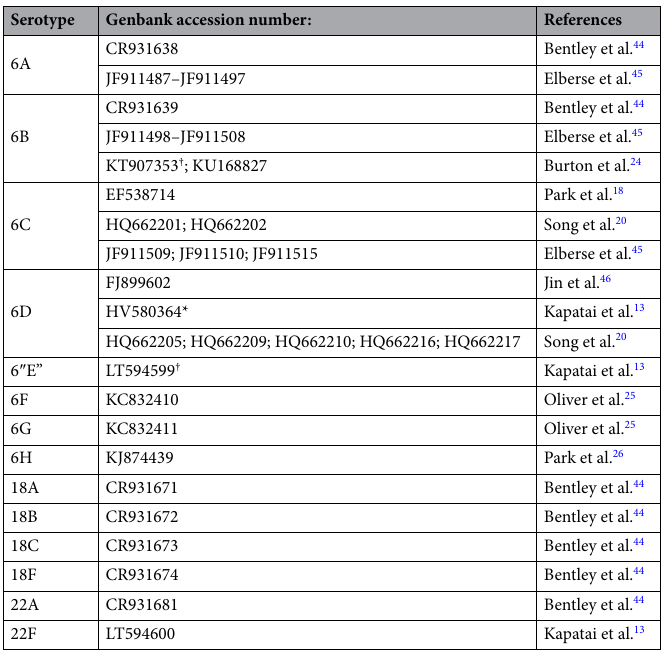
Table 2. Serotype-specific capsular sequences used to design the Dual Priming Oligonucleotide primers (DPO); Locked Nucleic Acid (LNA) probes and standard assays. † Serotype 6B ‘sub-class II’ or 6E; *Sequenced by Park, I. and Nahm,